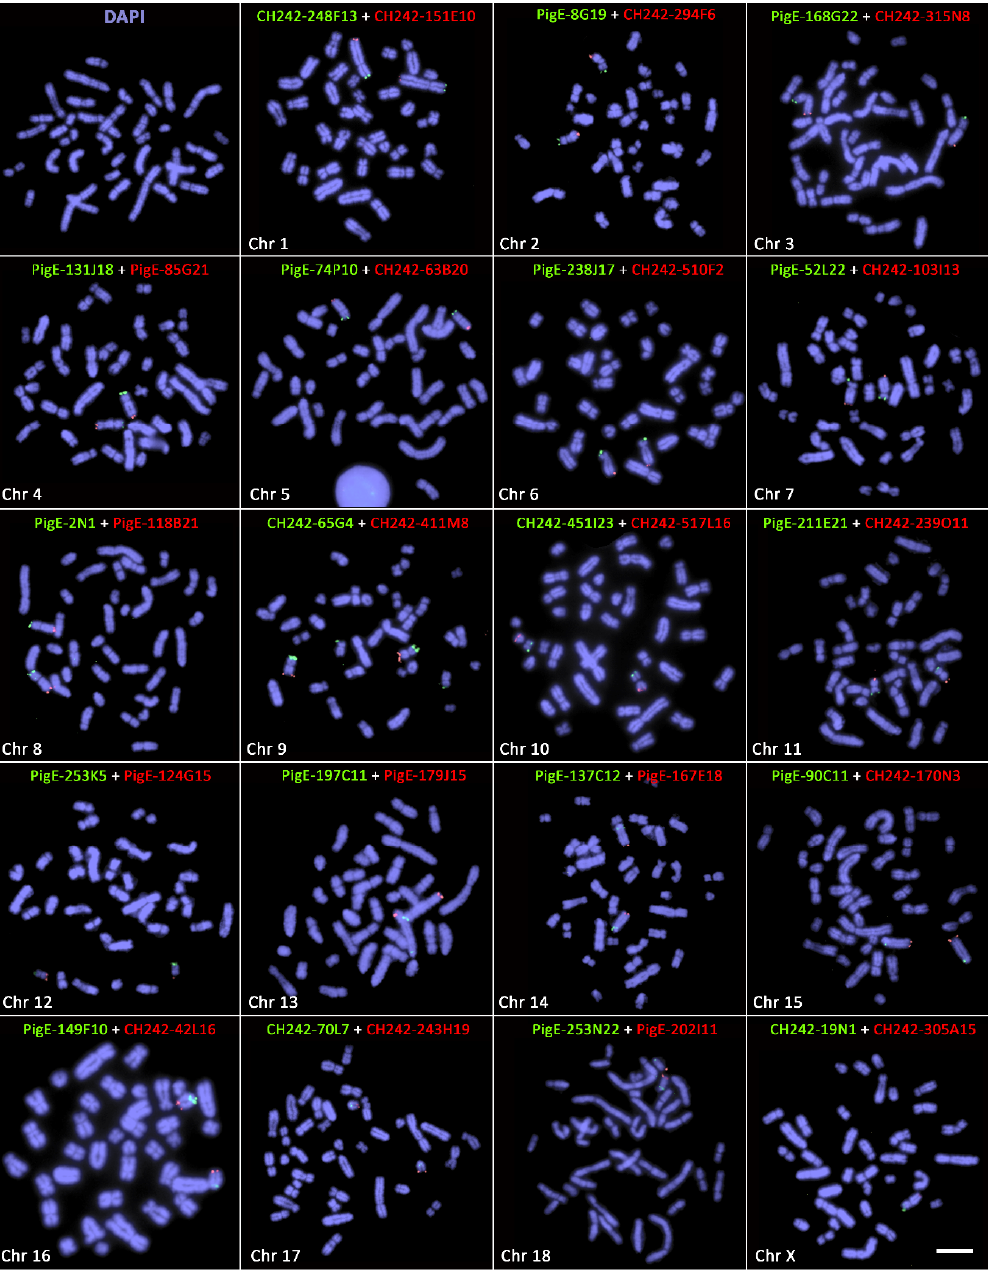
Figure 2. Fluorescence in situ hybridisation (FISH) signals with subtelomeric gene probes in boars with no balanced chromosomal rearrangements. Panel marked with Chr # represents the FISH signals for subtelomeric gene probes (green = specific to p-arm; red = specific to q-arm). Scale bar 10 µm.